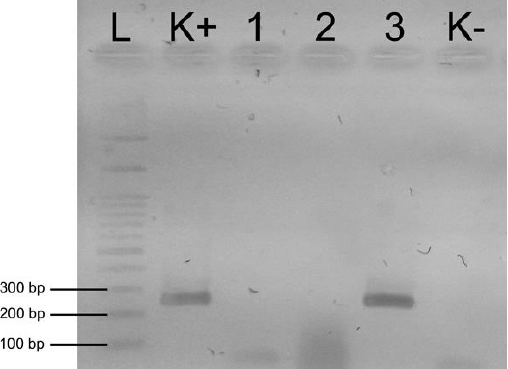
Figure 4. Gel electrophoresis of DNA amplification products obtained with primers LpCytb_F1 and LpCytb_R for detection of L. passim . L—100 bp ladder DNA marker; K + , positive L. passim control; 1–3,